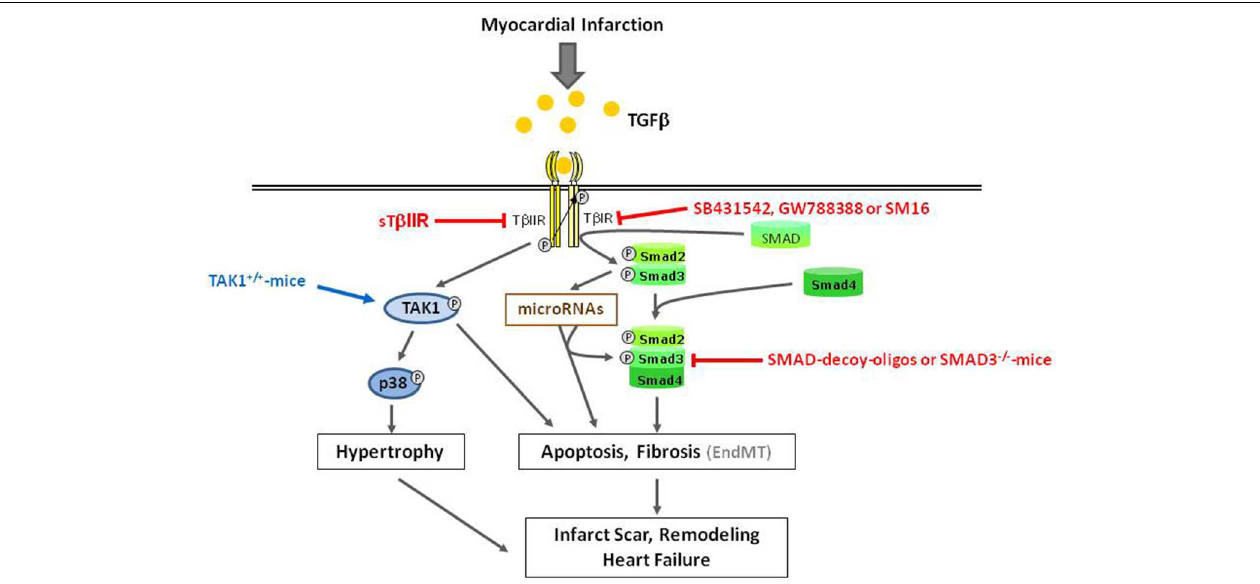
FIGURE 3 | Overview of detrimental TGF β -induced effects in ischemic reperfused myocardium. Gray arrows indicate physiological signaling pathways. Red and blue arrows/lines indicate pharmacological interventions used for characterization of signaling